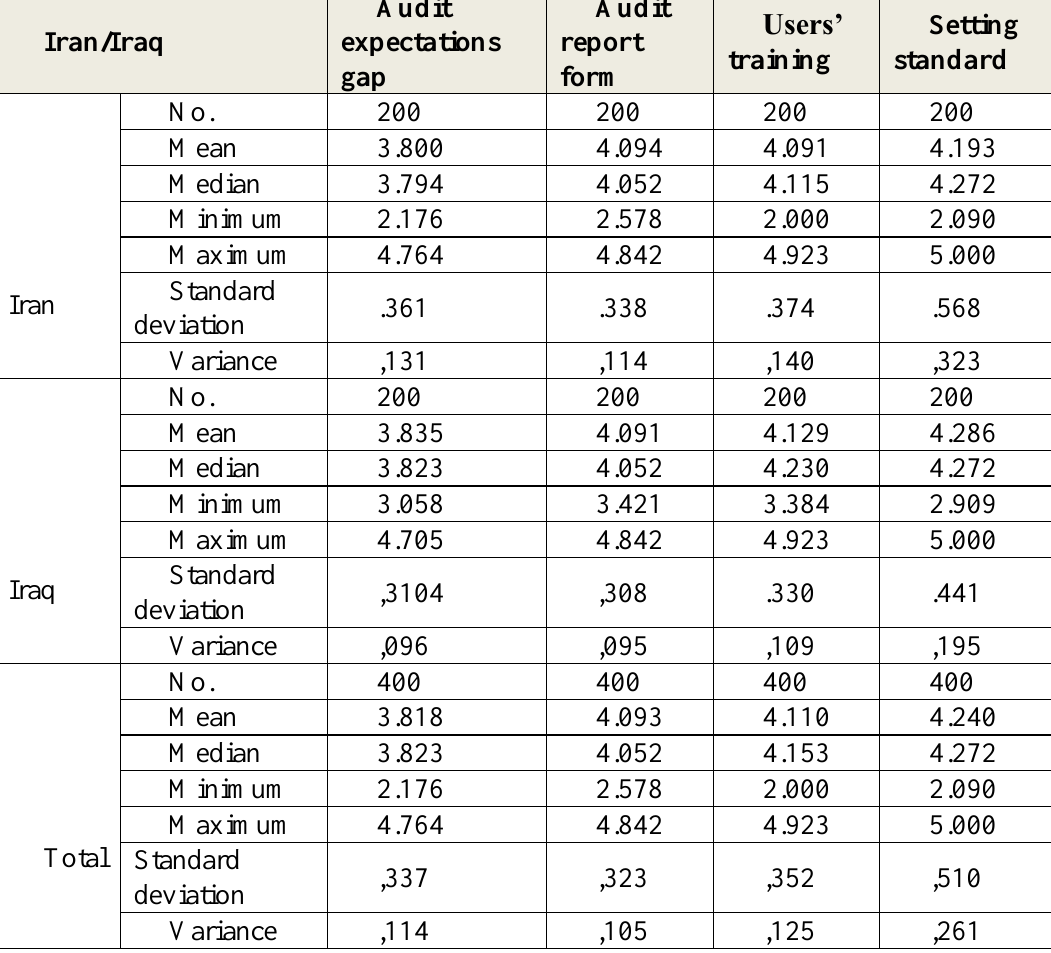
Table 2. Results of descriptive analysis of quantitative variables